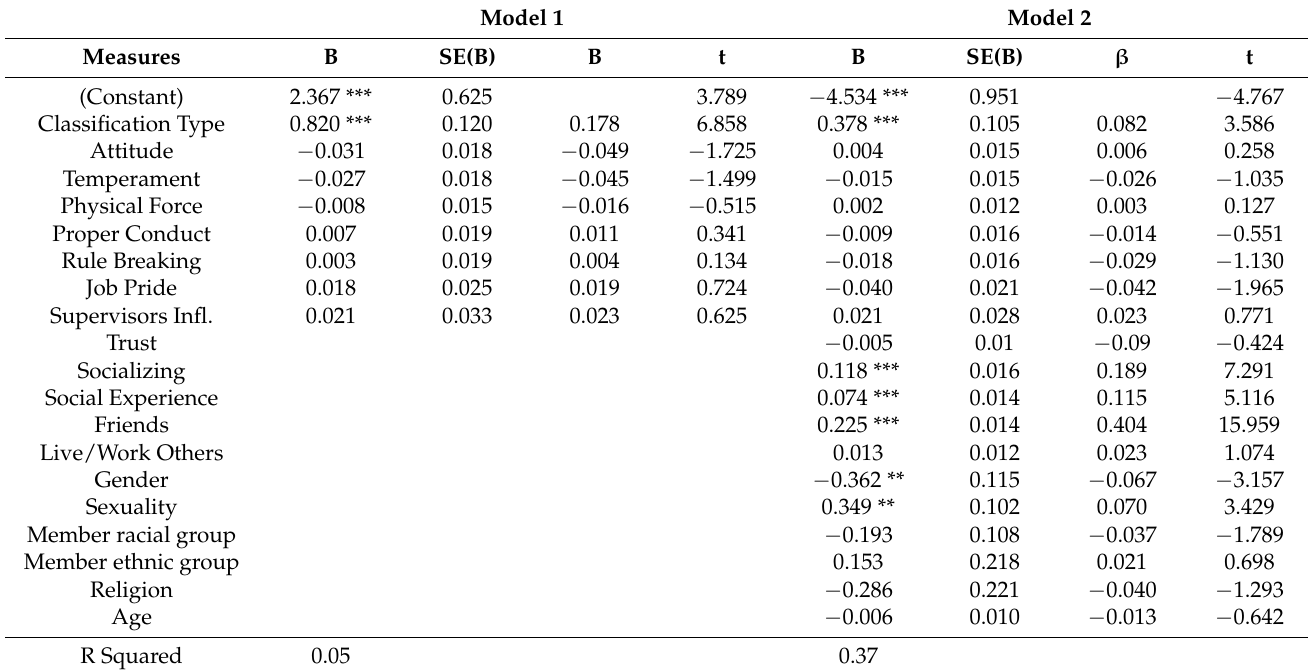
Table 4. Regression Analysis examining PRs’ and PSOs’ Perceptions of Policing Practice and Level of